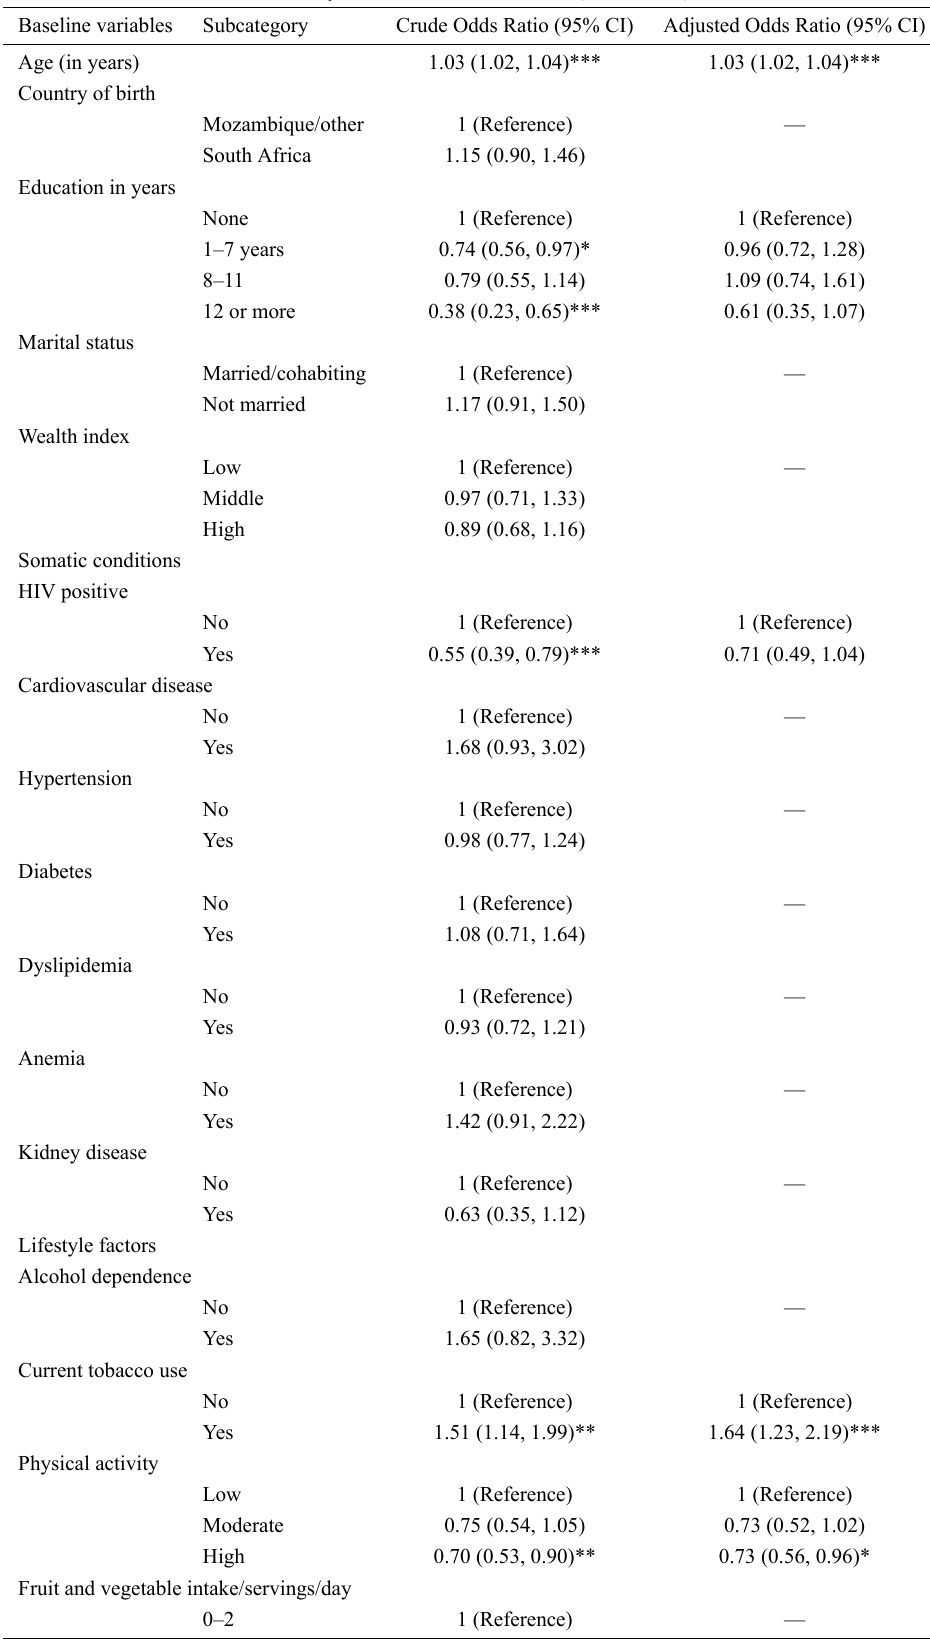
Table 5. Odds ratios for the association between chronic conditions, lifestyle factors and persistent low life satisfaction among men 40 years and older, HAALSI